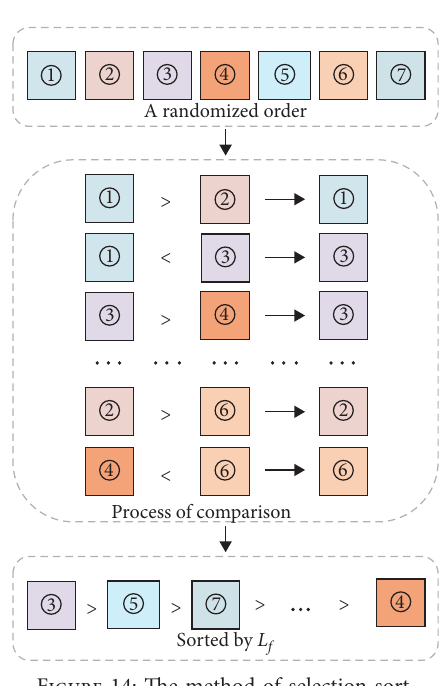
Figure 14: The method of selection sort.